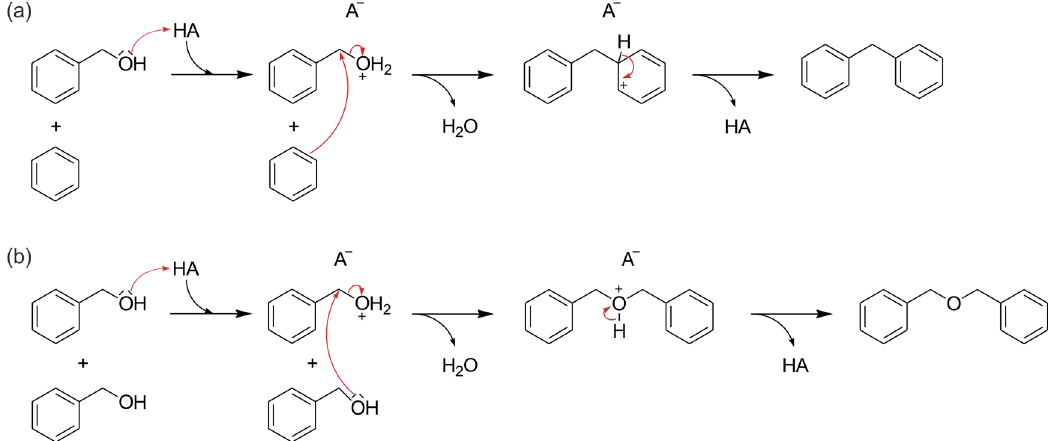
Figure 7. Reaction mechanism of the Brønsted acid (HA) catalyzed formation of ( a ) diphenylmethane and ( b ) dibenzyl ether [53,54].